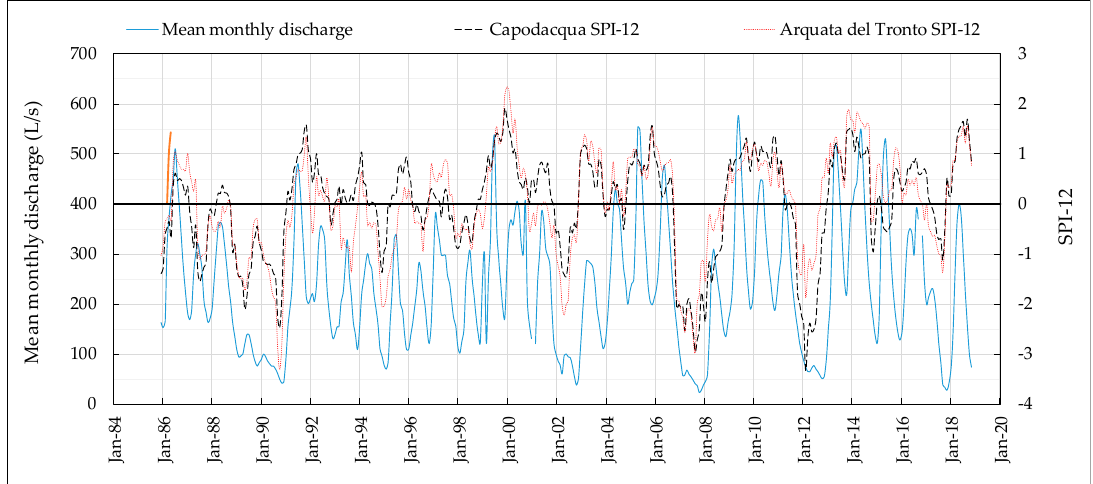
Figure 7. SPI-12 values from 1985 to 2019 for Capodacqua and Arquata del Tronto rainfall stations and mean monthly discharge values of Pescara di Arquata spring.